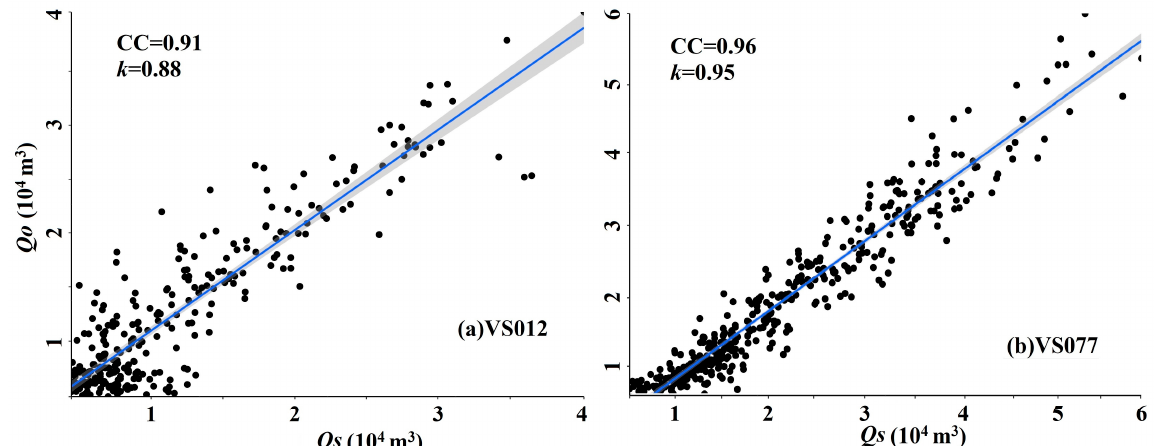
Figure 6. Scatter plots between simulated discharge from the Manning formula and observed discharge during 2008–2019. Note: The blue line is the fitted linear regression line and the blue shaded area denotes its 95% confidence interval. k is the slope of the linear regression line.